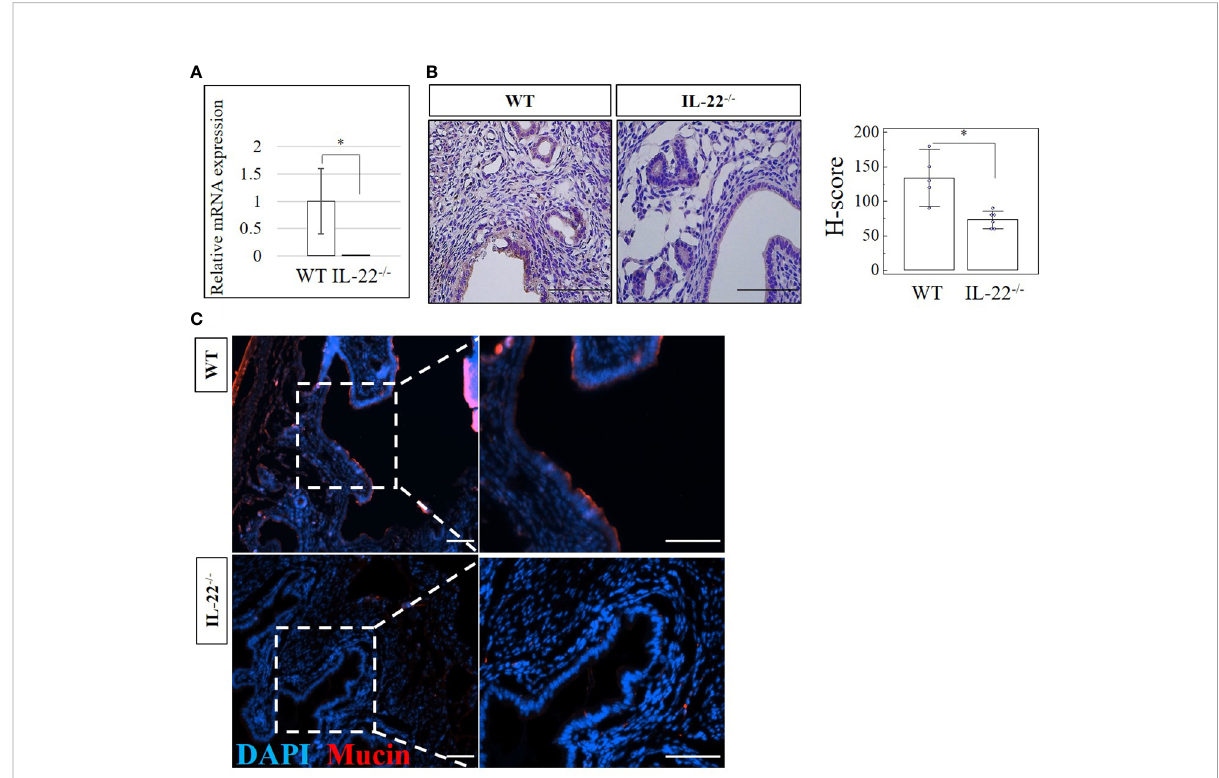
FIGURE 5 The expression of a cell surface pathogen protector mucin-1 in IL-22 − / − and WT mice. (A) IL-22 − / − , n = 6, and WT, n = 5, mouse uterine samples were harvested 48 h post intraperitoneal LPS injection. Total mRNA samples were extracted and processed by qRT-PCR to evaluate the expression of mucin-1. The data are provided as mean ± SEM from three independent experiments. (B) IL-22 − / − , n = 6, and WT, n = 5, mouse uterine samples were harvested 48 h post intraperitoneal LPS injection, frozen fi xed, and processed for IHC analysis. Original magni fi cation, ×40; scale bar, 100 µm. H-score of mucin-1 was calculated to measure whether the difference in the staining between the groups is statistically signi fi cant. The data from t-test are provided as mean ± SEM. (C) Representative IF images of mucin-1 in IL-22 − / − and WT mice. Nuclei staining in DAPI, blue; mucin-1 in TRITC, red. Original magni fi cation, ×10 and ×20; scale bar, 100 µm. WT, wild type; IL-22 − / − , IL-22 knockout; H-score, histological score; LPS, lipopolysaccharide; IHC, immunohistochemistry; IF, immuno fl uorescence. * p <